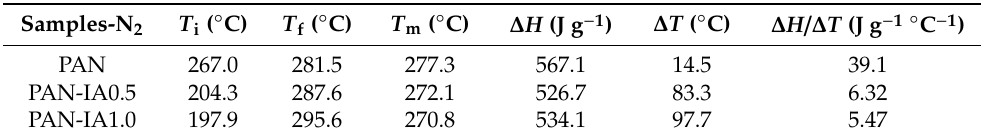
Figure 5. Differential Scanning Calorimetry (DSC) curves of ( a ) PAN homopolymer, ( b ) PAN-IA0.5 copolymers, and ( c ) PAN-IA1.0 copolymers in a nitrogen atmosphere. Table 3. Differential Scanning Calorimetry (DSC) parameters of PAN homopolymer and PAN-IA copolymers in a nitrogen atmosphere.